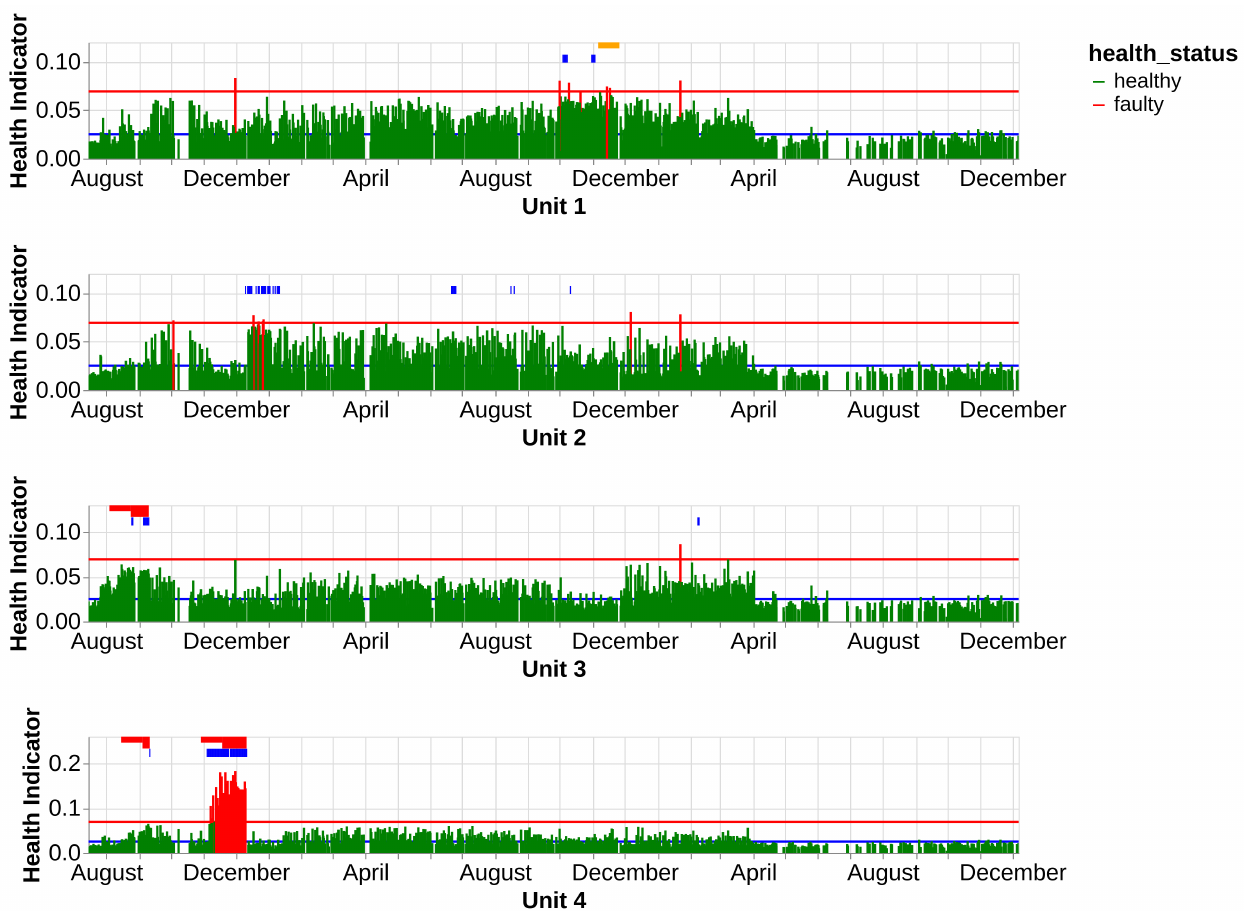
Figure 18. HI computed for the test tail tjyjdtaf